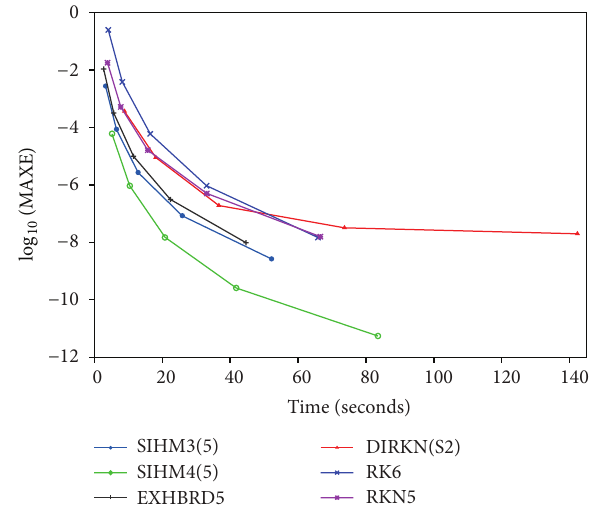
Figure 11: The efficiency curves for SIHM3 (5) and SIHM4 (5) methods for Lambert and Watson problem with ℎ = 0.125/2 𝑖 , 𝑖 = 1,...,5 .